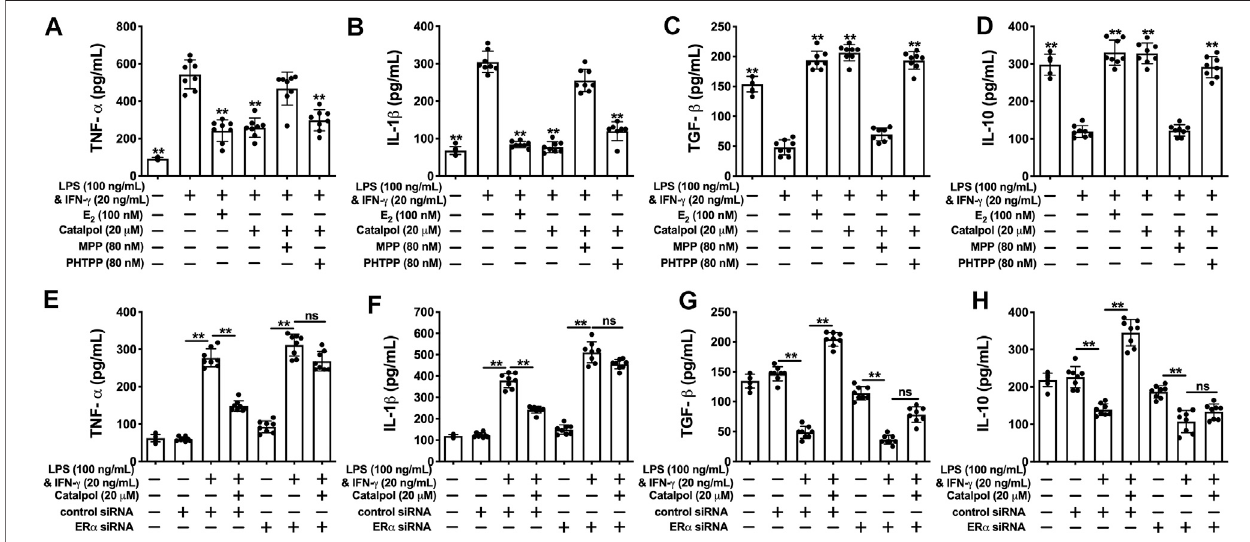
FIGURE5 | Catalpol attenuated in fl ammatory response in M1 macrophages through regulating ER α . (A, B) With MPP and PHTPP, effects of catalpol on the levels of pro-in fl ammatory cytokines (TNF- α and IL-1 β ) ( n (cid:2) 8); (C, D) With MPP and PHTPP, effects of catalpol on the levels of anti-in fl ammatory cytokines (TGF- β and IL-10) ( n (cid:2) 8); (E,F) ER α siRNA,effectsofcatalpolonthelevelsofpro-in fl ammatorycytokines(TNF- α andIL-1 β )( n (cid:2) 8); (G,H) WithER α siRNA,effectsofcatalpolonthelevelsof anti-in fl ammatory cytokines (TGF- β and IL-10) ( n (cid:2) 8). Data are expressed as mean ± SD. * p < 0.05, ** p < 0.01 vs. LPS&INF- γ group.